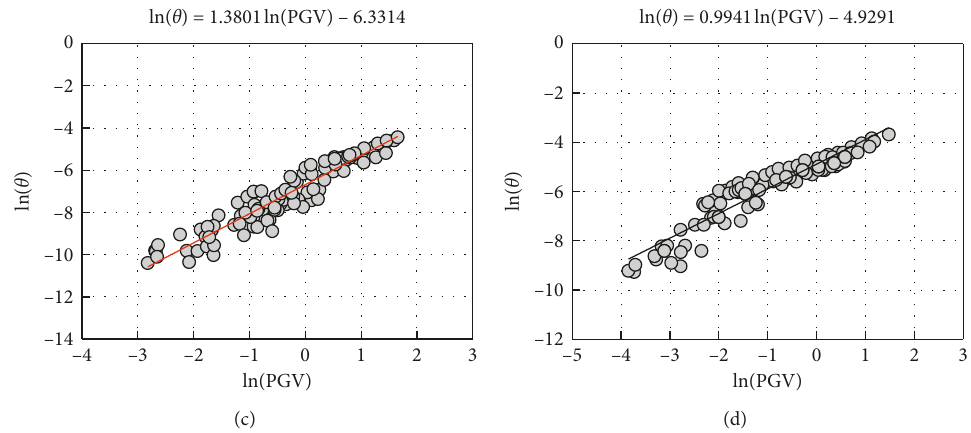
Figure 14: Linear regression analyses of IDA results. (a) Site I. (b) Site II. (c) Site III. (d) Site IV.